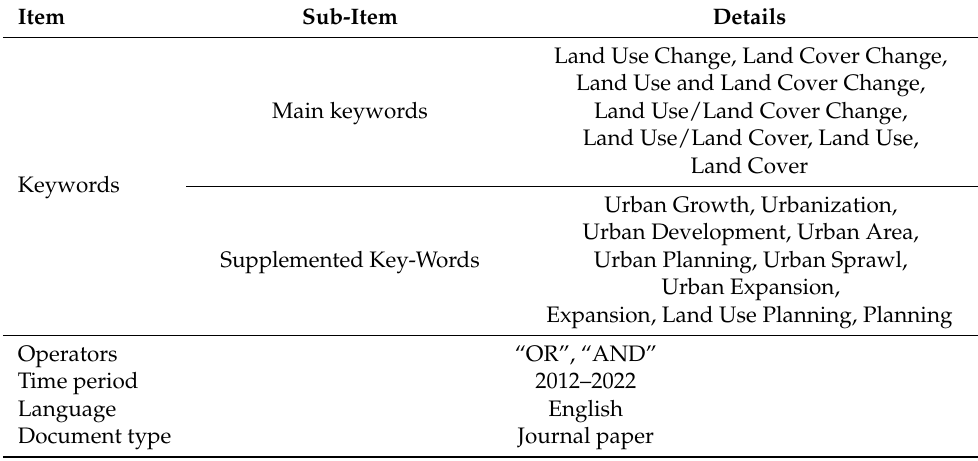
Table 1. Components of search